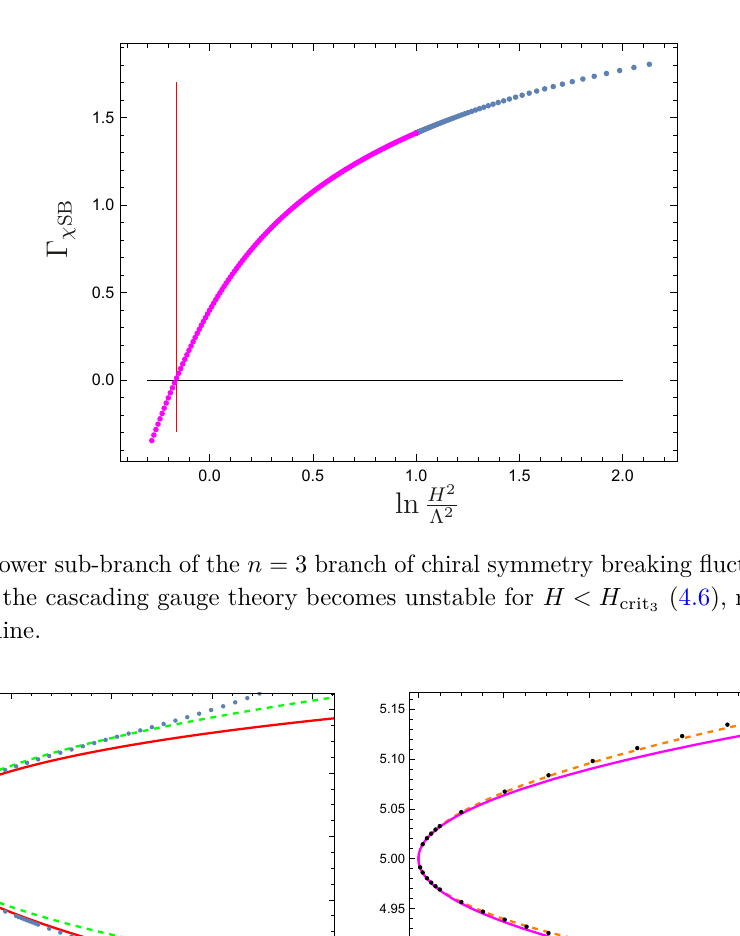
] of the chirally symmetric fluctuations about cascading Figure 8 . Attenuation Γ ( n ) ≡ − Im [ w ( n ) χ SB χ SB gauge theory TypeA DFP for H (cid:29) Λ . Dashed and solid curves are correspondingly the leading s and the first subleading order corrections to the conformal spectra, see